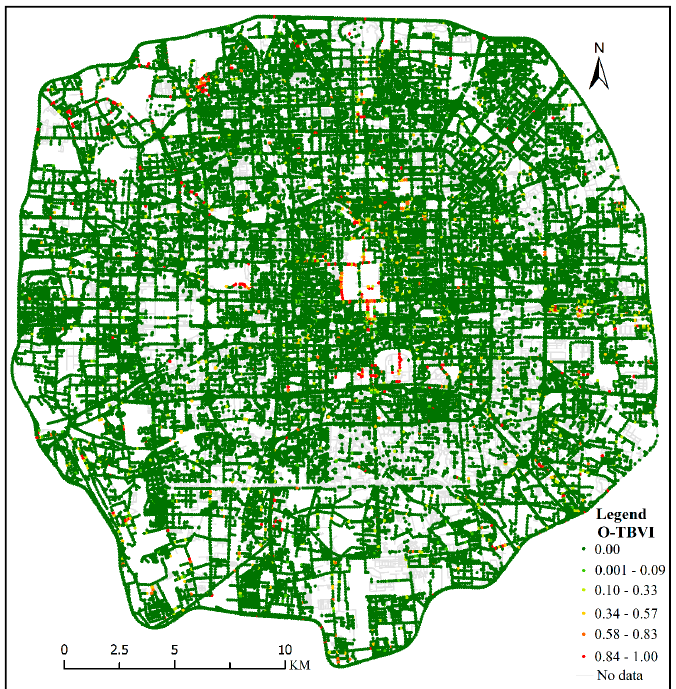
Figure 7. Spatial distribution of the TBVI of the official-style buildings.